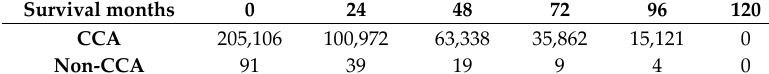
Figure 1. Kaplan–Meier curve and risk table of clear cell adenocarcinoma in comparison to other carcinomas of the urinary bladder.